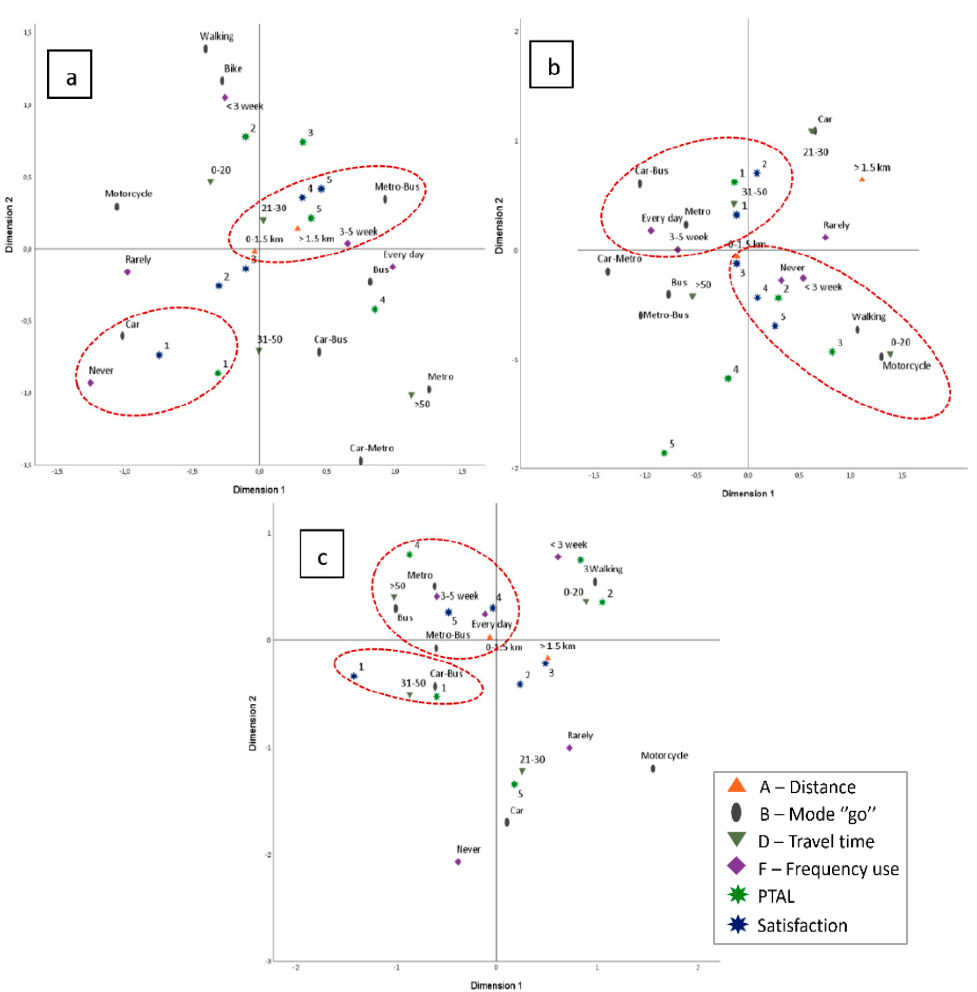
Figure 9. MCA analysis of PTAL satisfaction and travel habits for ( a ) science and technology campus; ( b ) humanities; ( c ) economics (social science).